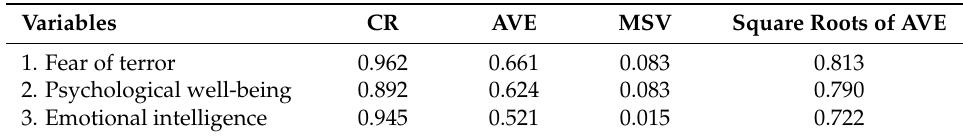
Table 3. Values of composite reliability, maximum shared variance, average variance extraction, and its square